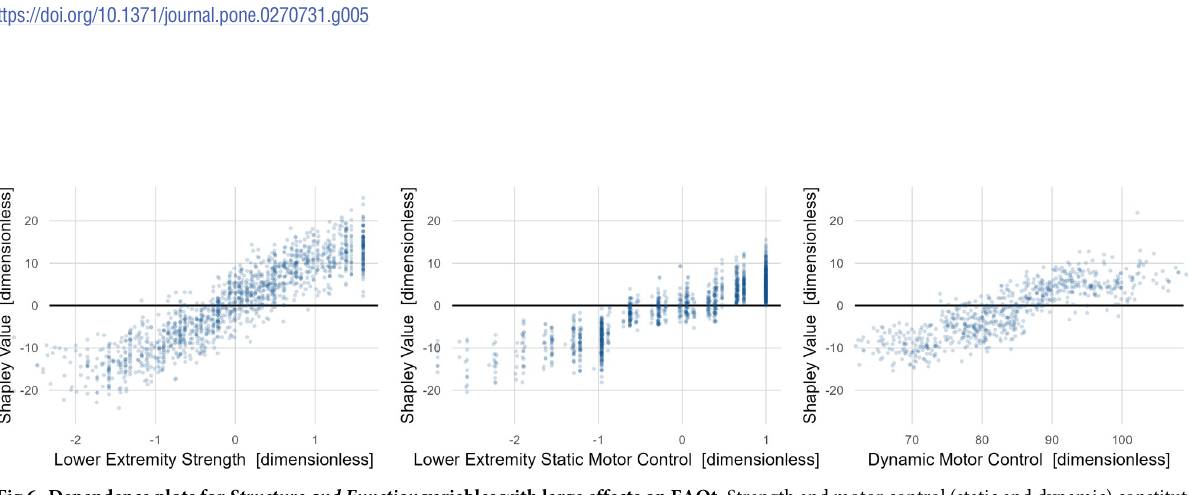
Fig 6. Dependence plots for Structure and Function variables with large effects on FAQt. Strength and motor control (static and dynamic) constitute the top causal contributors to mobility as measured by the FAQt. The positive effect of dynamic motor control plateaus at around 90, which is 1 SD below